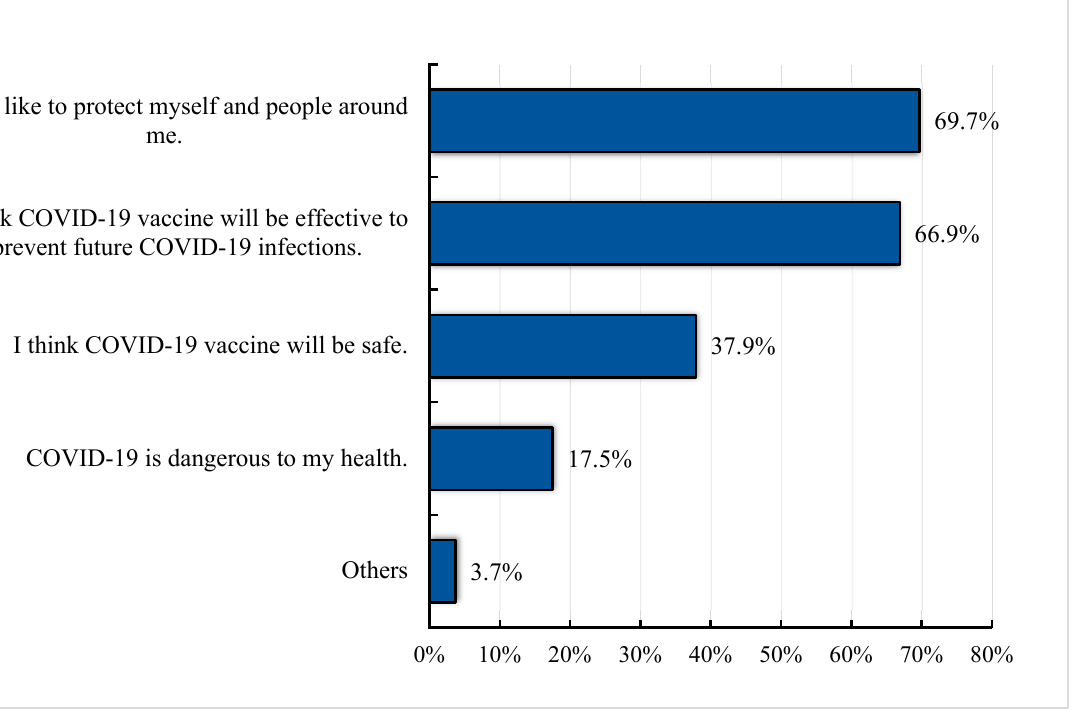
Figure 1. Bar graph showing different reasons for the acceptance of COVID-19 vaccine among the study participants in Indonesia. Total number of responses: 1726